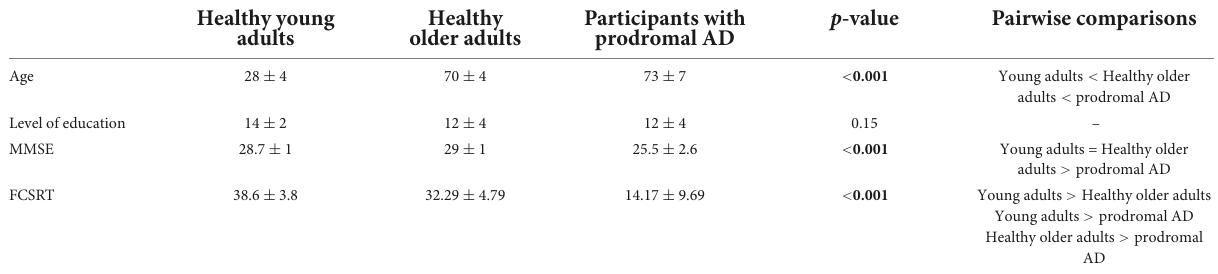
TABLE 1 Pre-inclusion assessment.